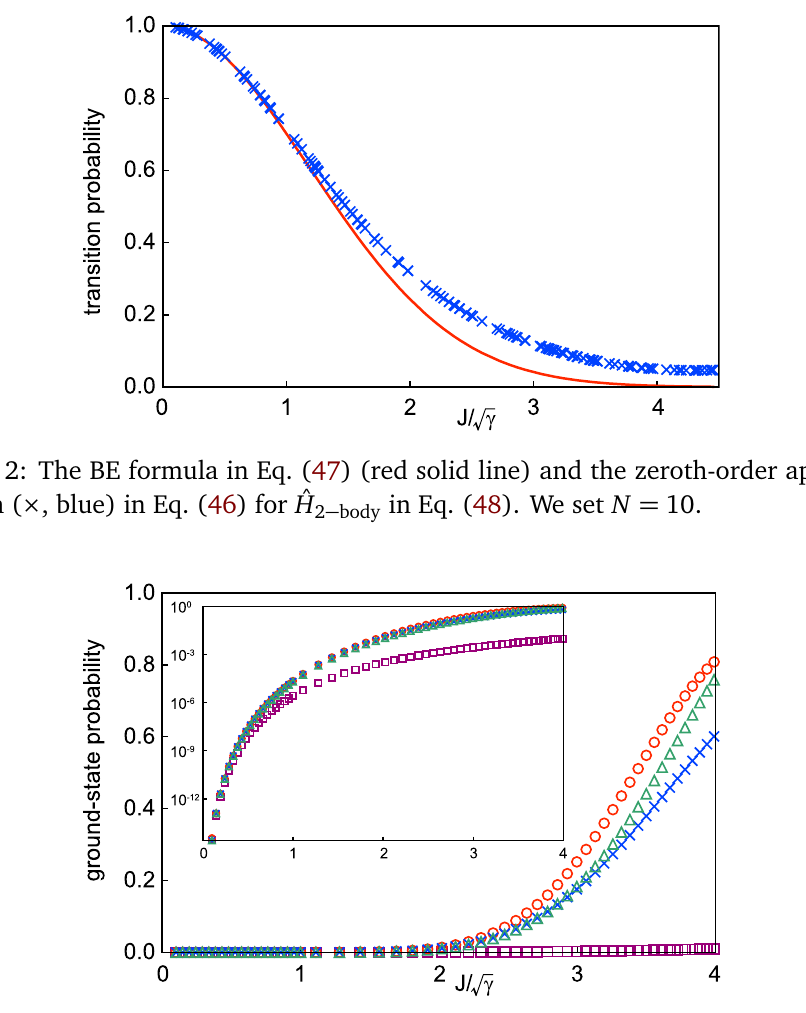
2 − body without ˆ Z in 2 − body,0 0